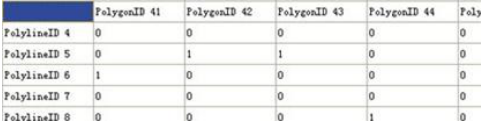
Figure 8. Topological relation--intersecting matrix